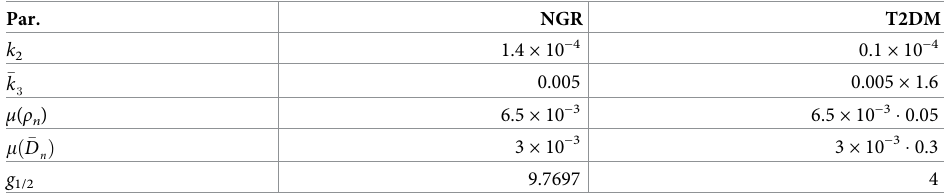
Table 3. Parameters varying values for T2DM patient undergone an IVGTT.